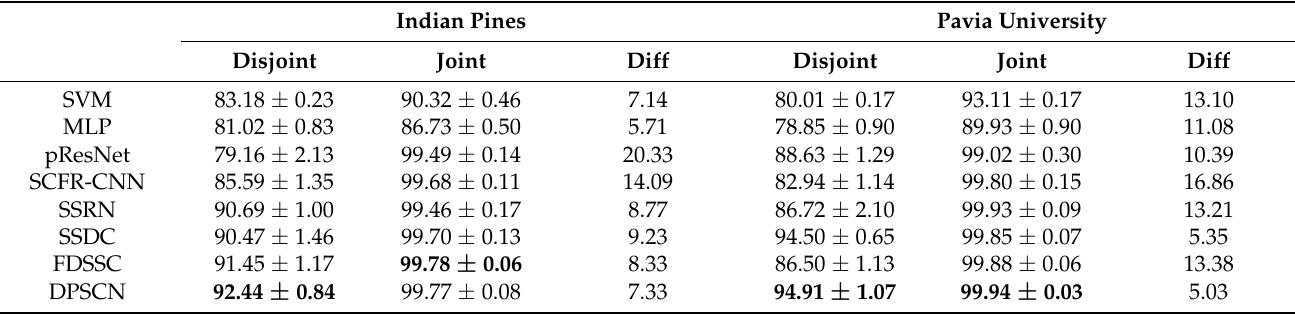
Table 10. Comparison (in terms of OA) between different classification models using randomly selected samples and spatial–disjoint samples. Indian